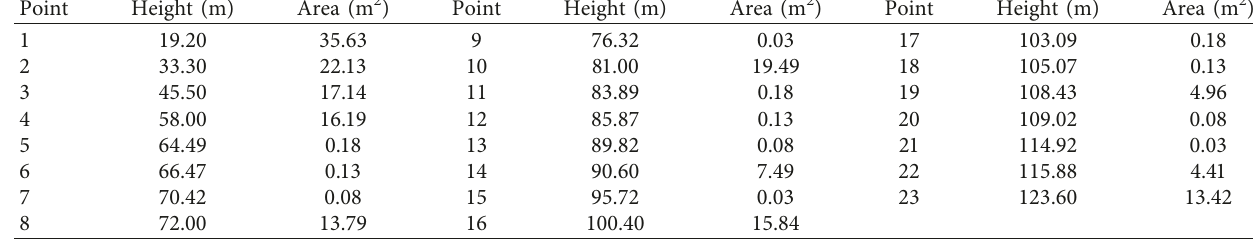
Table 3: The positions of wind load and windward areas.